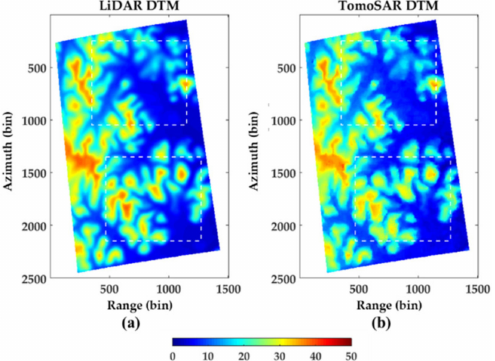
Figure 7. The DTM estimated by the SKP-IMLE method: ( a ) LiDAR DTM; ( b ) TomoSAR DTM. The white dotted areas are the estimated DTM and LiDAR DTM of the two regions of interest (ROI).